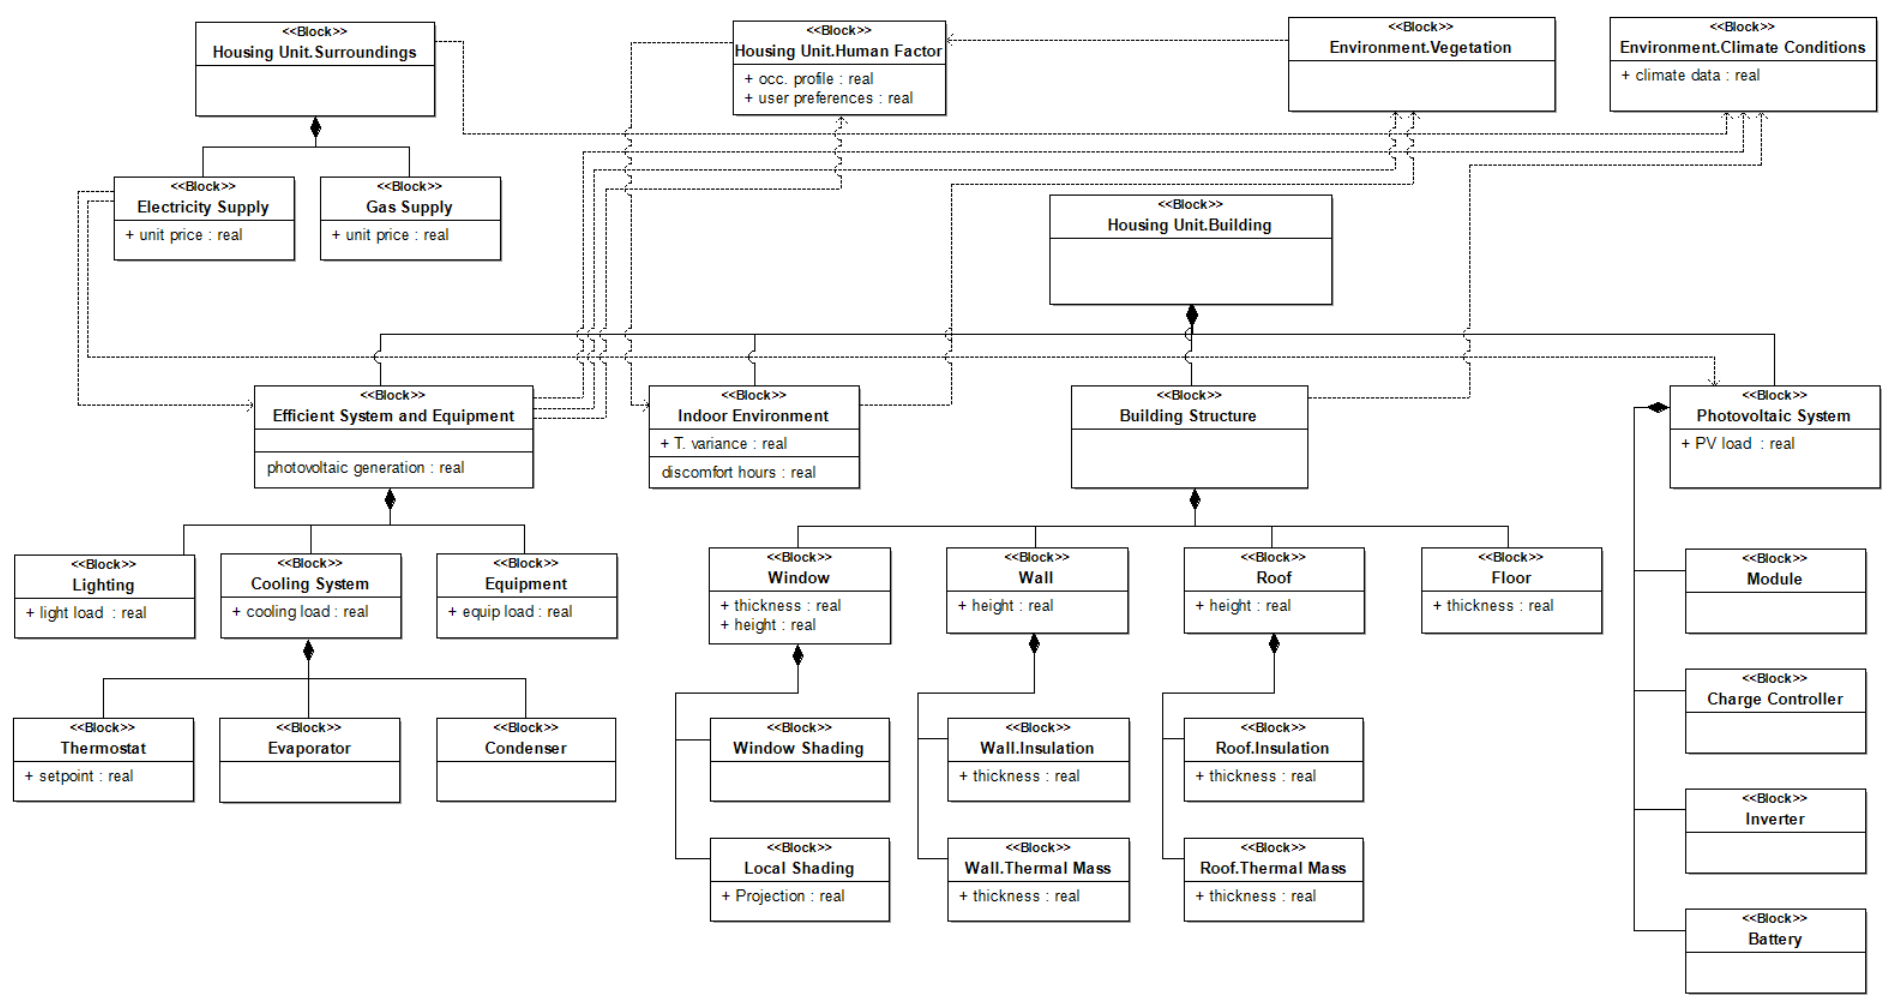
Figure 6. BDD of the physical components in a generic model of a residence in the considered Chitré estate; all blocks are elements of either package “Housing Unit” or “Environment”.